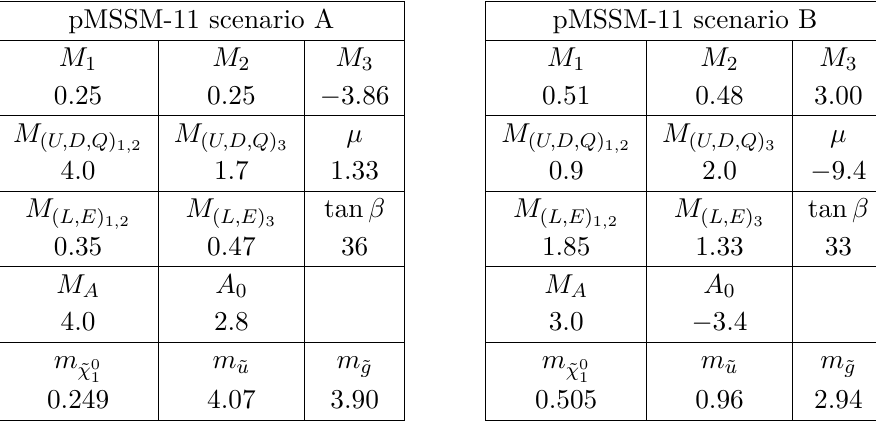
illustrative purposes, we include also our new NLL+NLO predictions (green). While they do not systematically increase the NLO cross section for the masses chosen here, the scale uncertainty is reduced by about a factor of two relative to the NLO